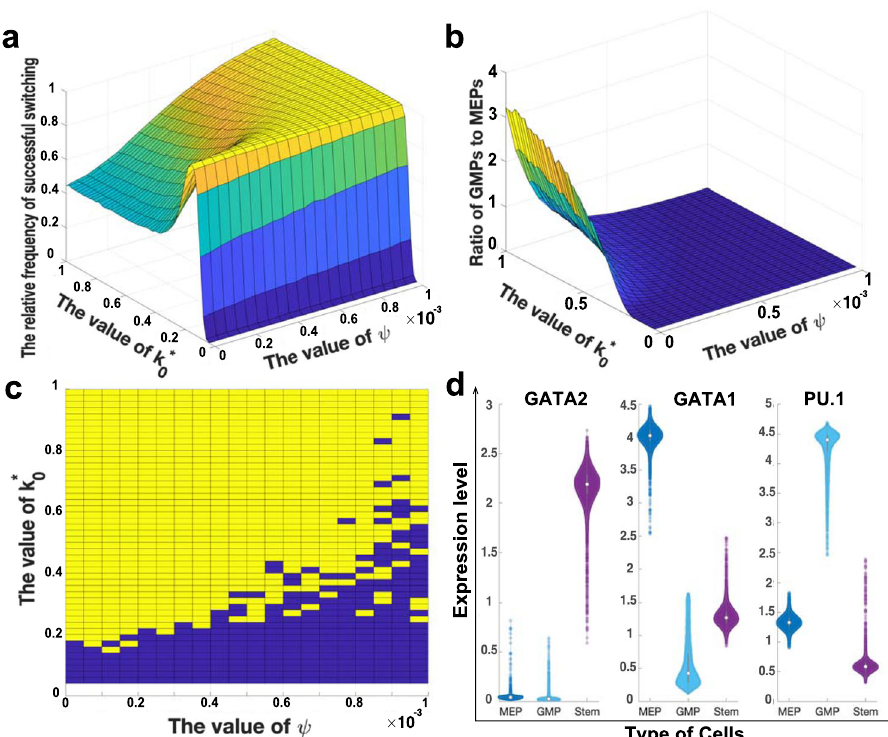
Fig. 5 Distributions of different cell types derived from stochastic simulations. a Frequencies of cells having successful switching for each ; ψ Þ . b Ratios of GMP cells to MEP cells when cells have successfully switched in a for each set of parameters ð k (cid:3) set of parameters ð k (cid:3) 0 ; ψ Þ that generate stochastic simulations with four steady states as shown in Fig. 4 (yellow part) or with two or three c Parameter sets of ð k (cid:3) 0 states (blue part). d Violin plots of natural log normalised (expression level per cell + 1) distributions for three genes in different cell states ¼ 0 : 52 and ψ = derived from stochastic simulations with parameters k (cid:3) 0